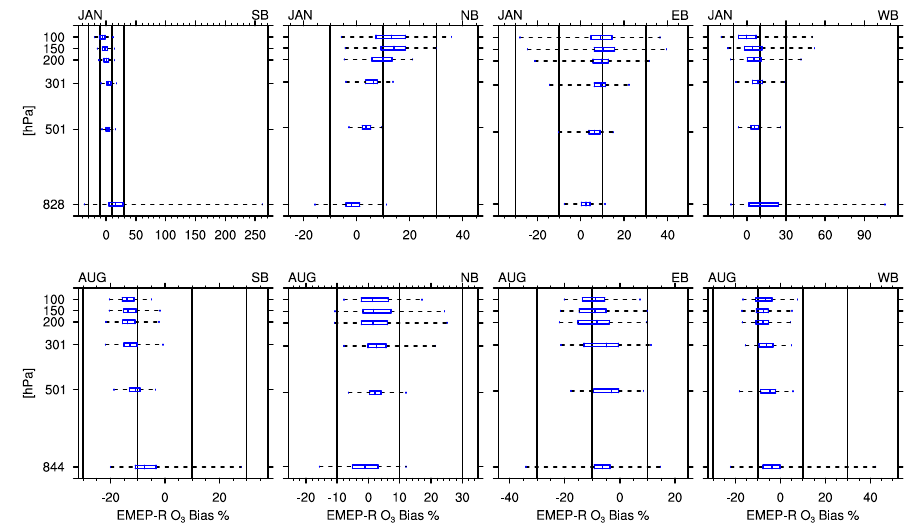
Figure 5. Same as Fig. 3, but for OMI and O 3